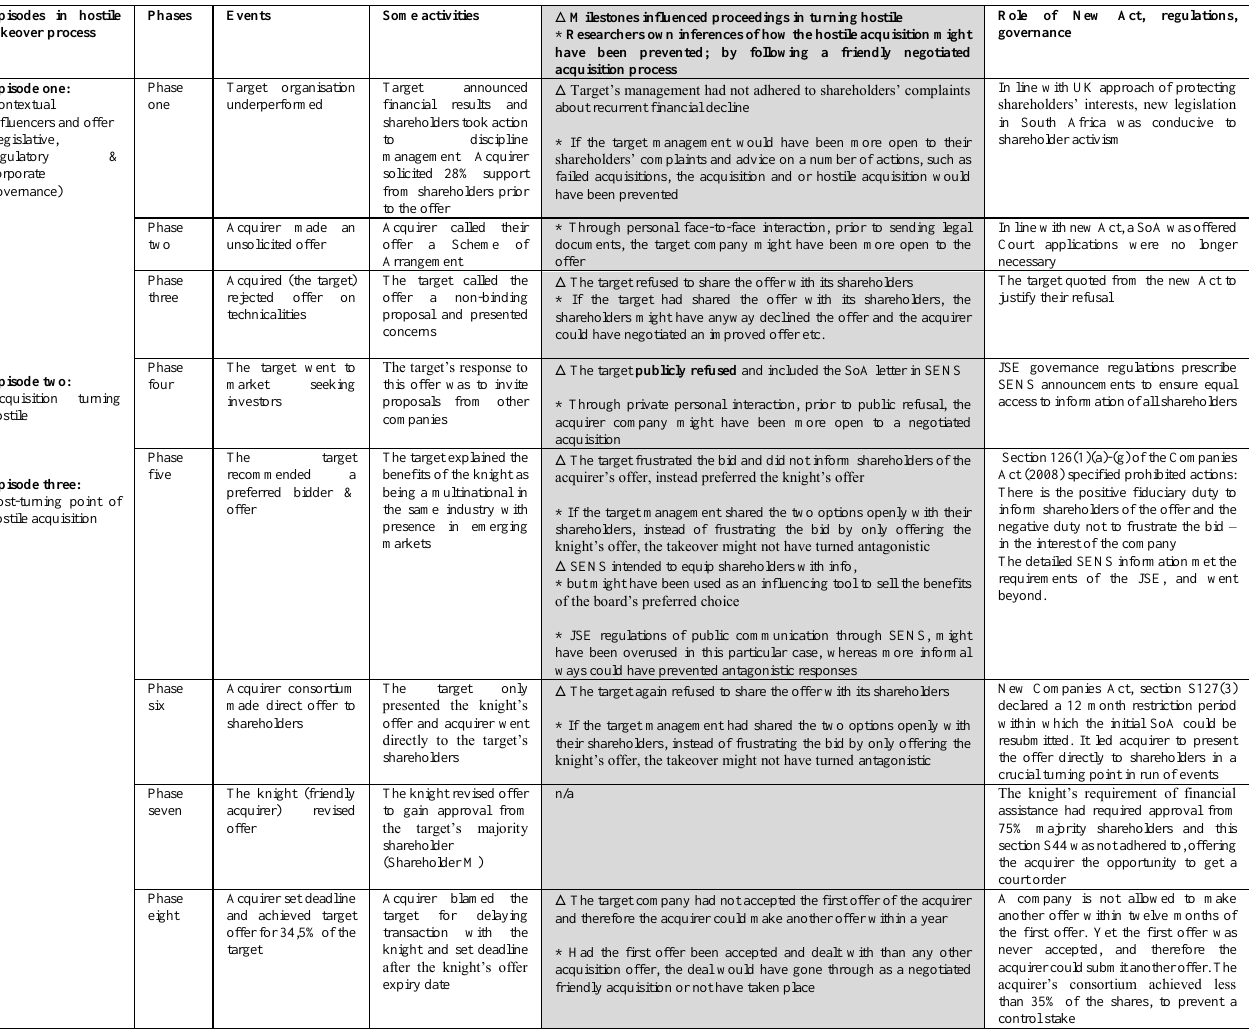
Table 1: Three episodes with eight distinct phases of a particular hostile takeover case, including milestones that influenced the proceedings to turn hostile and the role of legislation, regulation and governance Episodes in hostile takeover